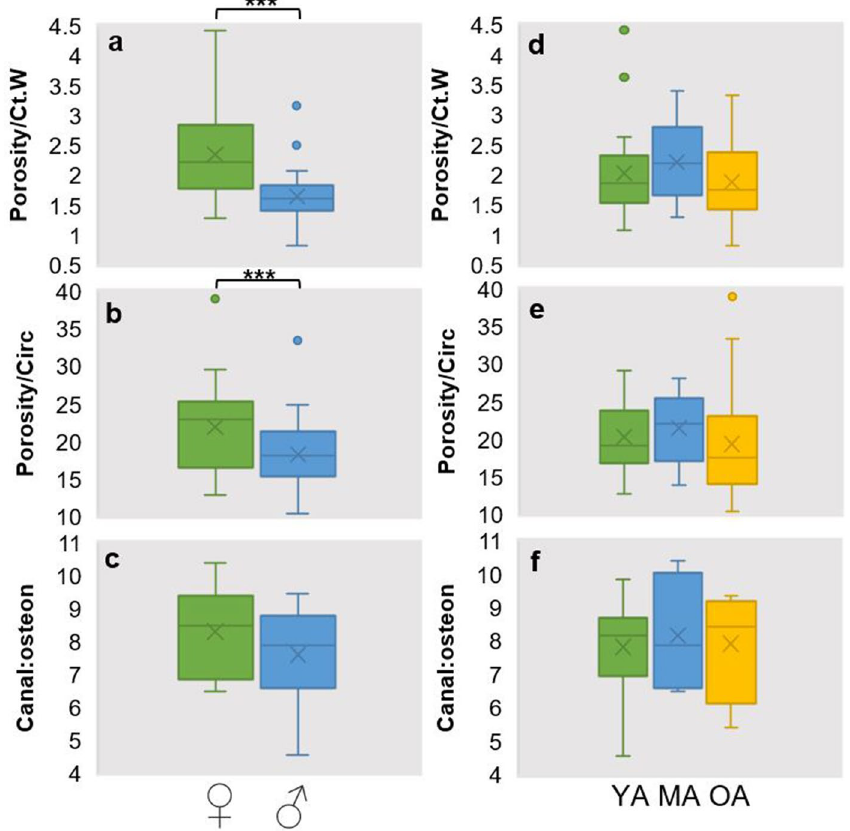
Figure 3. Simple boxplots illustrating differences in vascular porosities adjusted by different measures of femoral bone size ( Circ circumference of midshaft, Ct.W cortical width), and ratio of Haversian canal area to osteon area, compared between the sexes (boxplots a – c ), and age-at-death categories ( d – f ; where YA young adults, MA middle-aged adults, OA older adults). *** p < 0.001 using Mann Whitey U test (see Table